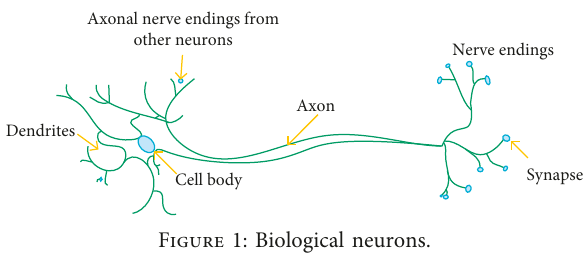
Figure 1: Biological